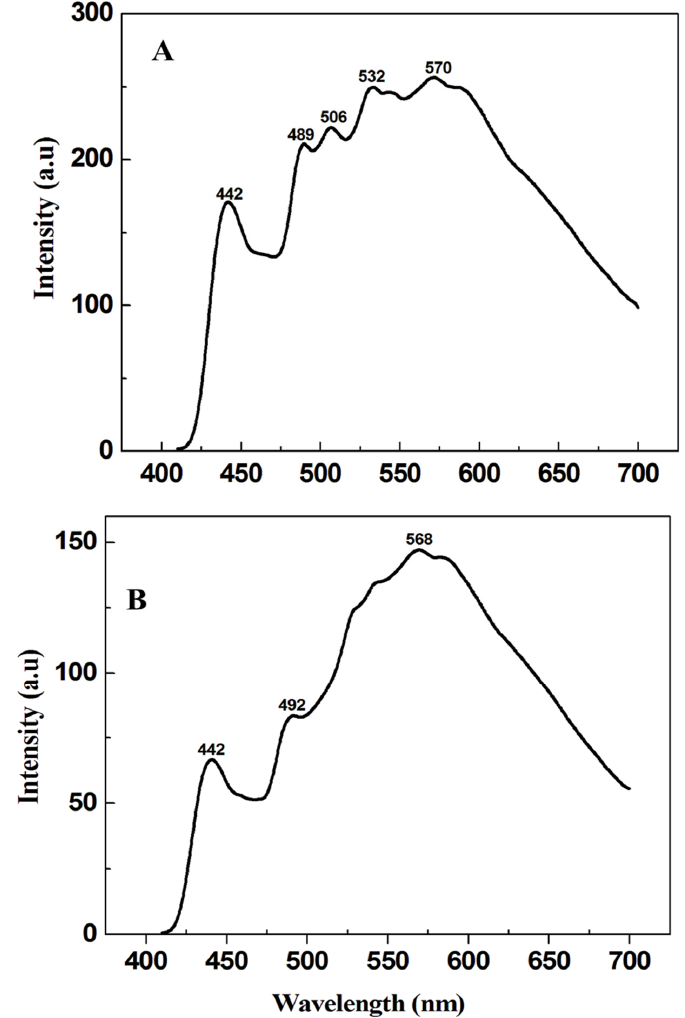
Figure 6. Photoluminescence of TiO 2 nanoparticles (( A ) for TiO 2 NPs at 1 h, and ( B ) for TiO 2 NPs at 5 h).